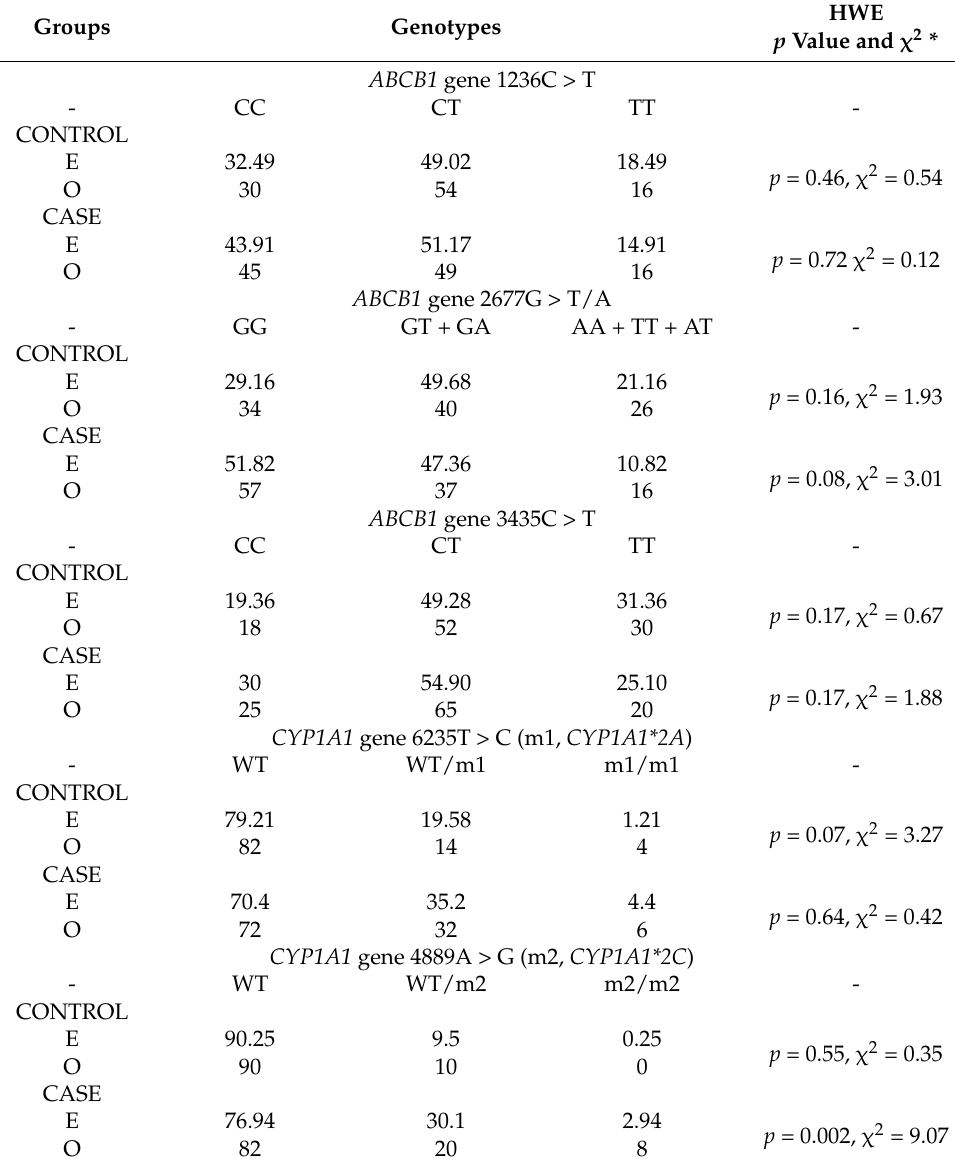
Table 2. Hardy-Weinberg equilibrium (HWE) for ABCB1 and CYP1A1 variants in case and control groups according to expected (E) and observed (O)